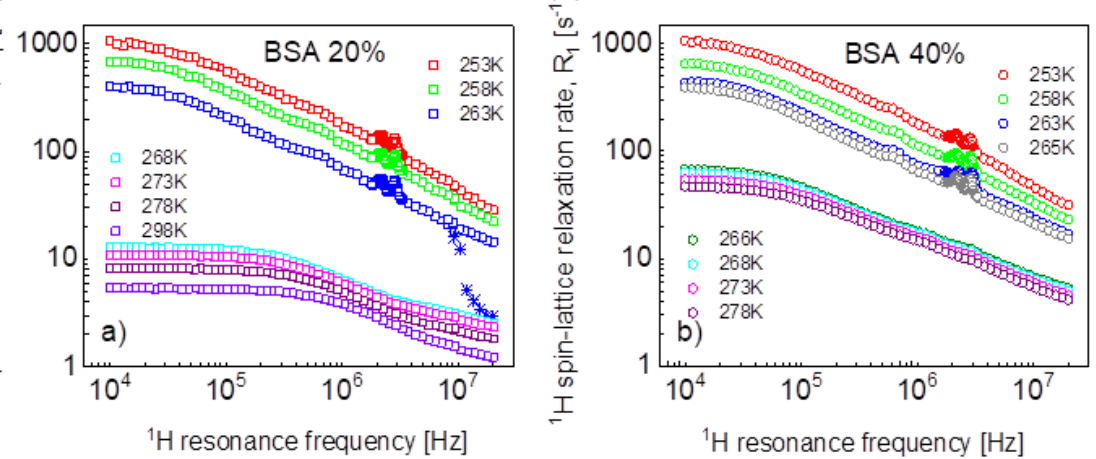
Figure 1. 1 H spin-lattice relaxation rates for BSA–water mixtures versus temperature, ( a ) 20%wt of BSA, ( b ) 40%wt of BSA. Stars show the changes in the relaxation rates upon cooling down. Looking at Figure 1a, one sees that between 268 K and 263 K, the dynamics of the system changed due to the freezing of the water fraction. Actually, the freezing process has been captured—stars in Figure 1a. The temperature was set to 263 K, and, after 60 min, the experiment began. The relaxation rates at the highest frequency correspond to those at 268 K, then in the course of time with progressing freezing, the relaxation rates reach the values of the relaxation data represented by blue squares that have been obtained at 263 K after waiting the next 60 min. The data for 263 K and below show Quadrupole Relaxation Enhancement (QRE) effects (quadrupole peaks). For the mixture including 40%wt of BSA (Figure 1b), the freezing temperature has been carefully investigated—it has turned out that at 266 K, the system remains liquid, while it freezes at 265 K. Here, one also sees QRE